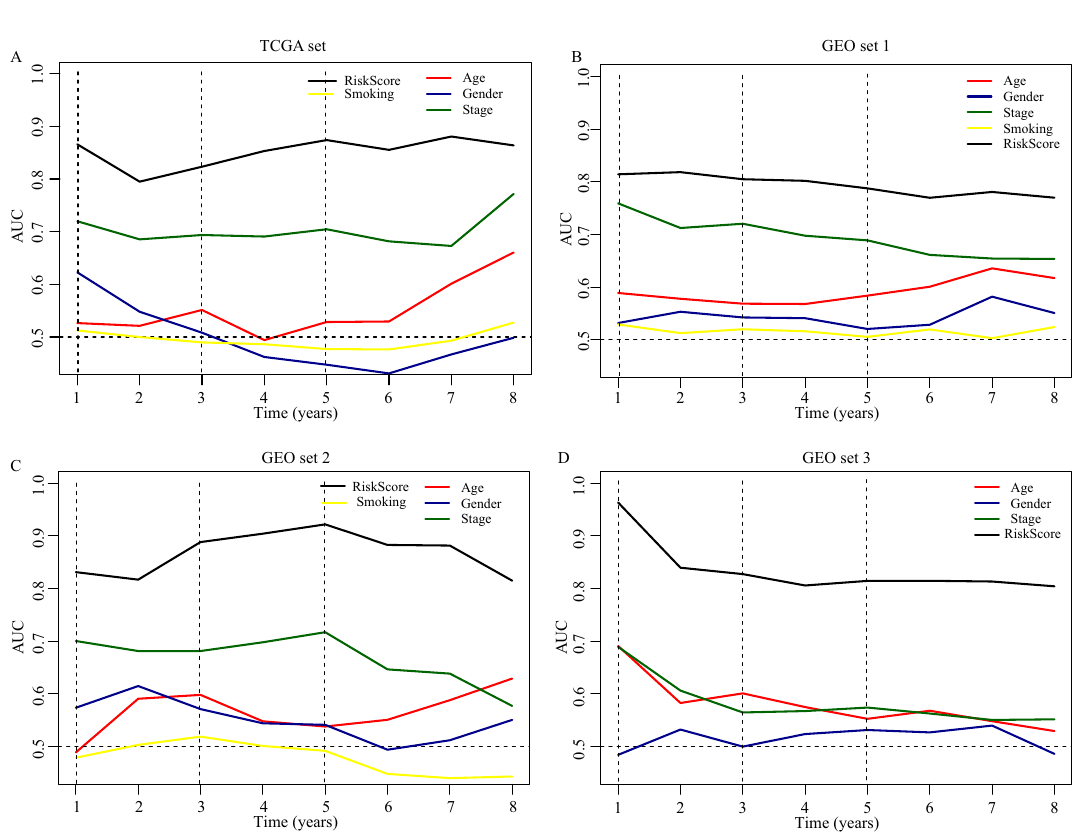
Figure 2. The survival prediction performance of the IRGPs signature. ( A ) The time-dependent receiver operating characteristic curve (ROC) in the TCGA set, ( B ) in the GEO set 1. ( C ) in the GEO set 2. ( D ) in